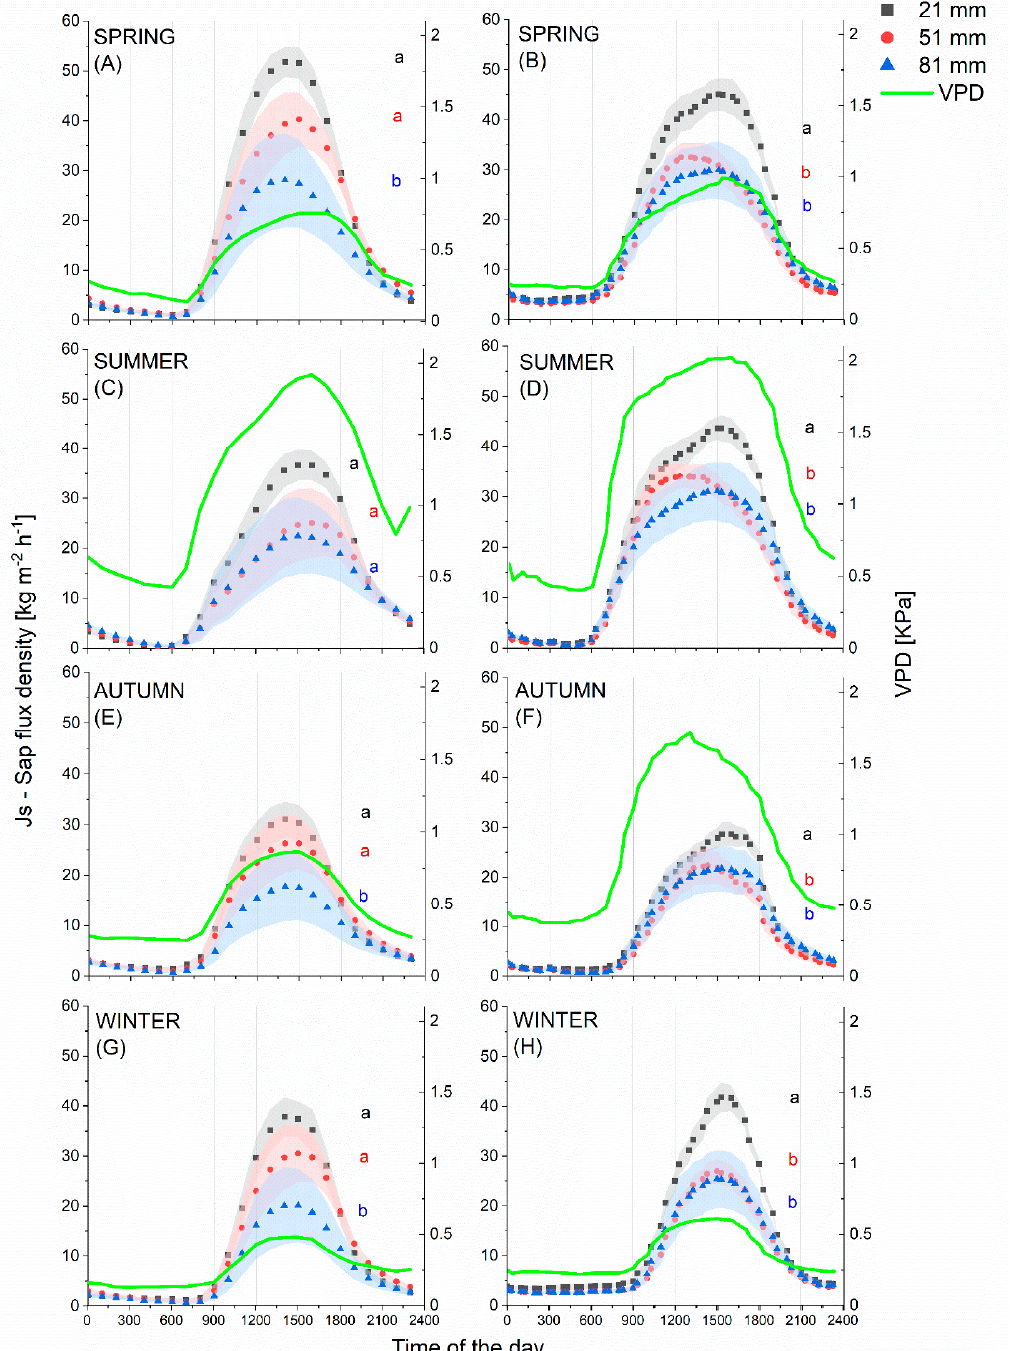
Figure 1. Diurnal variation of Js in the 3 radial depths and VPD in the different seasons of the year during the two study periods (dry period: A , C , E , G ), wet period: B , D , F , H ). Different letters indicate significant differences between the daily curves of Js in the 3 radial depths at p < 0.05 within each season and period. Symbols represent mean values ( n = 5 trees) and the shaded bands represent ± SE of the means.